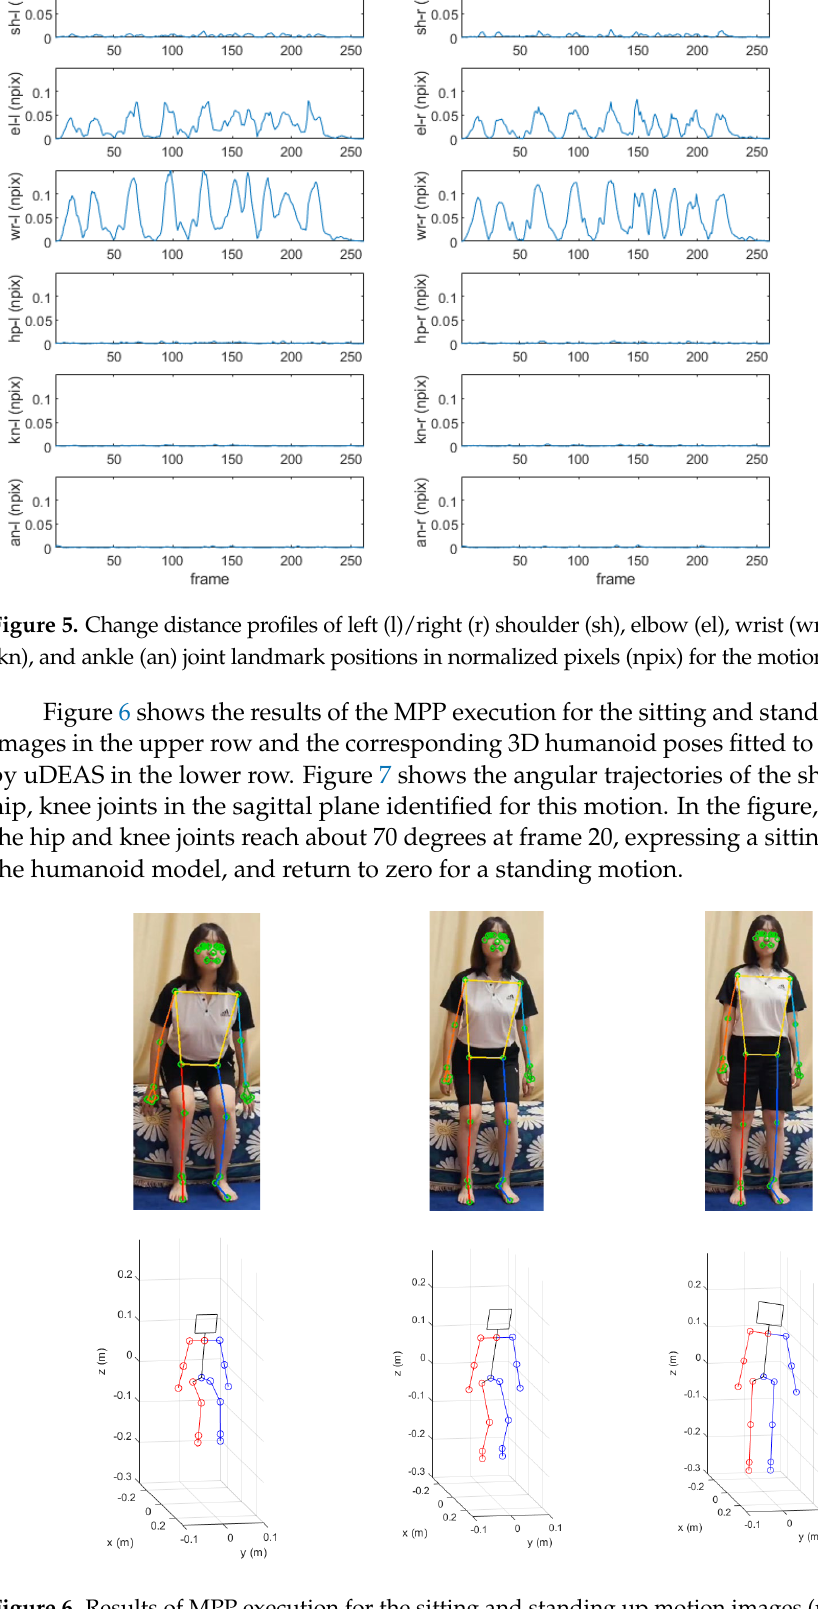
Figure 4. MPP execution results for the motion of raising the arm upward and then lowering it to the side.